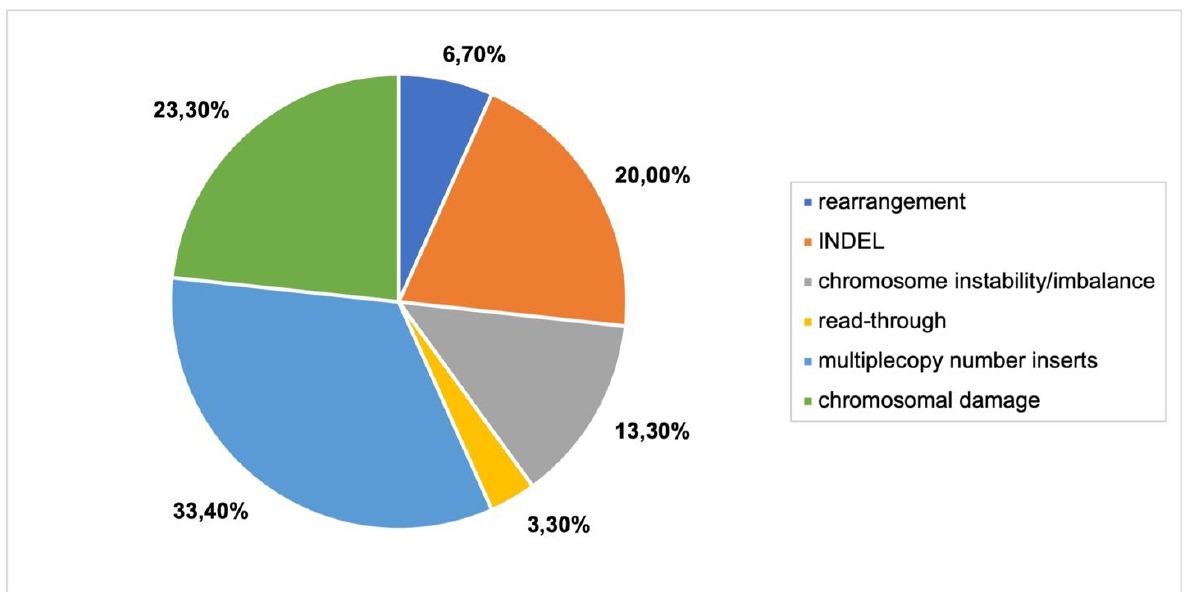
Figure 5. Genomic outcomes from biolistic bombardment. N = 7 articles. Colors in graph correspond to legend in Figure 4A.